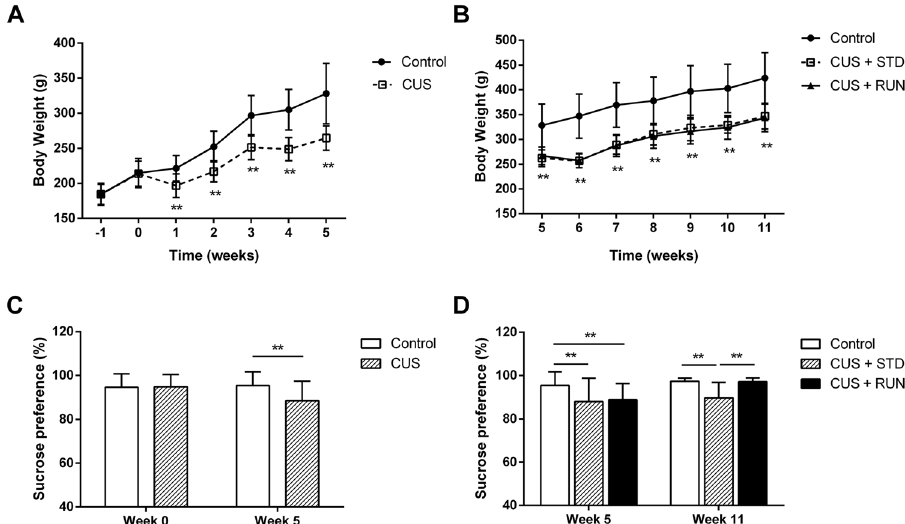
Fig. 2 The effects of running exercise on the depressive-like behaviors of CUS-exposed rats. A Body weights of the rats in the control group ( n = 23) and the CUS group (n = 37) during the fi rst 7 weeks. B Body weights of the rats in the control group ( n = 23), the CUS + STD group ( n = 17) and the CUS + RUN group ( n = 20) during the last 7 weeks. C Sucrose preferences of the rats in the control group ( n = 23) and the CUS group ( n = 37) at different stages. D Sucrose preferences of the rats in the control group ( n = 23), the CUS + STD group ( n = 17), and the CUS + RUN group ( n = 20) at different stages. ** p < 0.01. CUS + STD CUS + standard, CUS + RUN CUS +